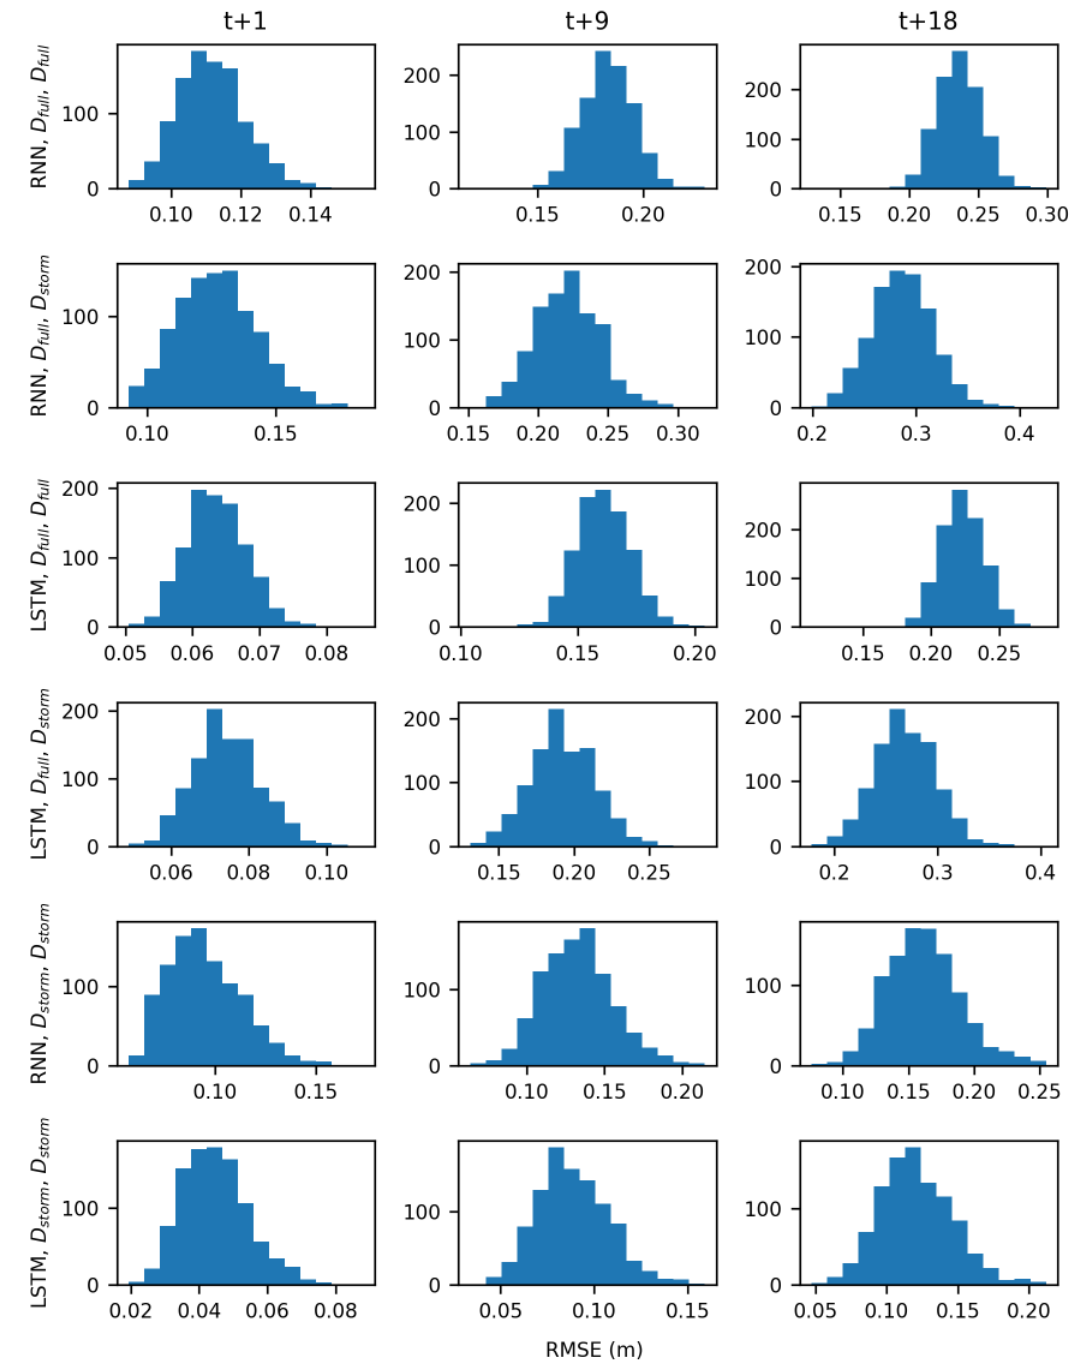
Figure A3. RMSE distributions for GW3 using observed data. Columns represent the forecast horizons t + 1, t + 9, and t + 18. Rows are specified as model type, training data, and testing data.